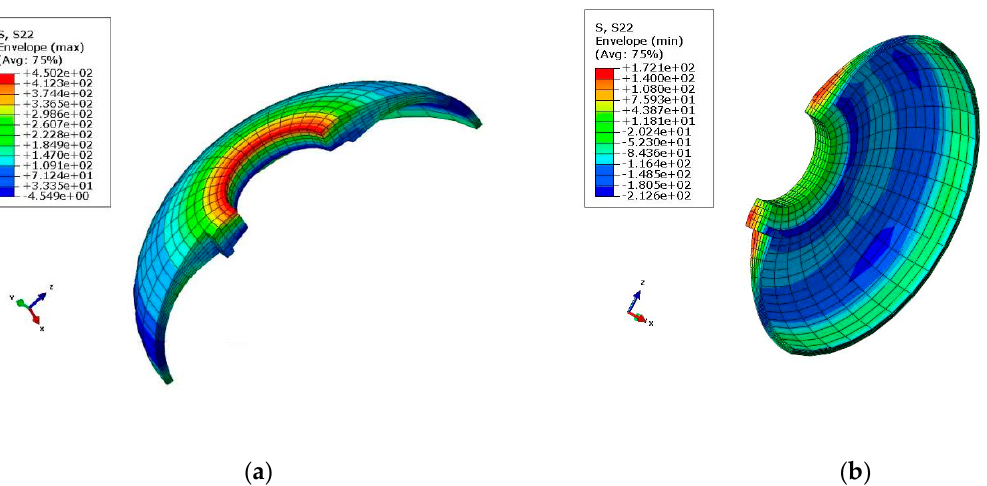
Figure 6. Maximal tensile and compressive stress diagrams in the X -direction: ( a ) Tensile stress ( σ x